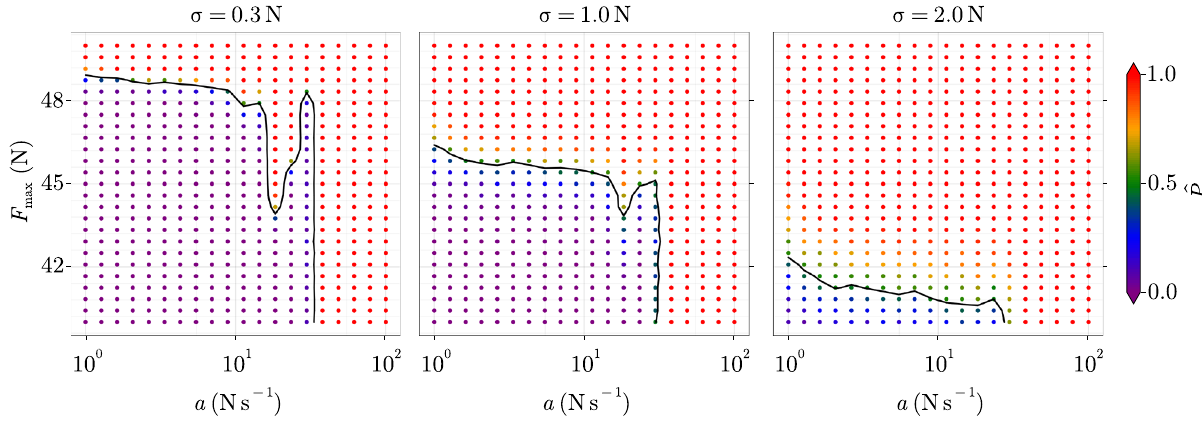
Figure 4. Probabilistic tipping pattern of the PLO in the ramp-parameter space for various noise amplitudes σ . The initial perturbation is fixed to (cid:31) x 1 represents the separation function F min,tip ( a ) between ˆ P tip < 0.5 and ˆ P tip > 0.5